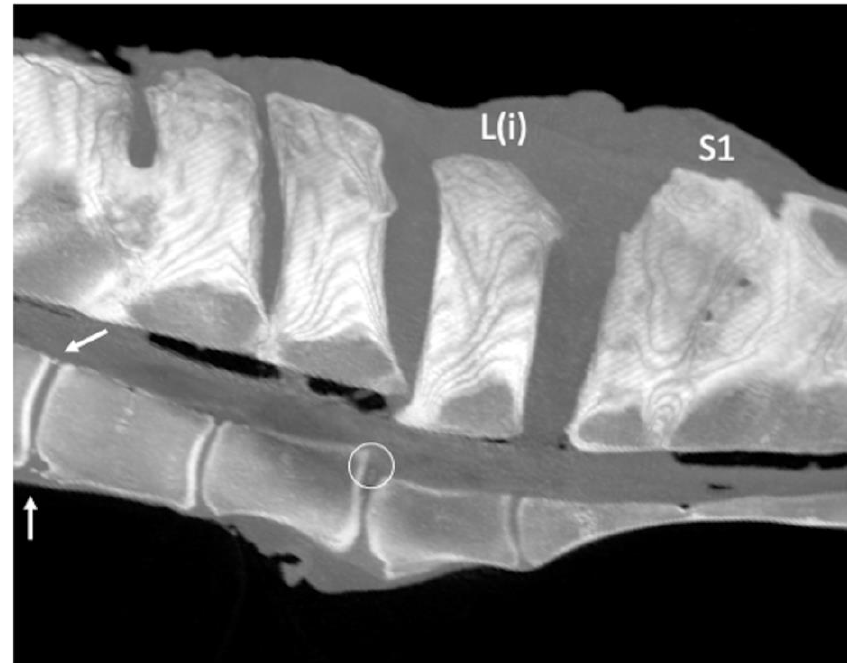
Figure 7. Sagittal multiplanar reconstruction computed tomographic image of the lumbosacroiliac specimen 1 using maximum intensity projection (MIP) (cranial is toward the left) showing the presence of a ventral displacement of L(i) and sacrum relative to the more cranial lumbar vertebrae (ventral spondylolisthesis). Note two small hyperattenuating structures at the level of the dorsal portion of the intervertebral disc (circle), L(iv)-L(iii) intervertebral osteophytes (white arrows) on both the dorsal and ventral aspects, and L(iv)-L(iii) spinous processes (SPs) fusion, as well as a fusion of the sacral SPs. L(iv): fourth to the most caudal lumbar vertebra; L(iii): third to the most caudal lumbar vertebra; L(ii): second to the most caudal lumbar vertebra; L(i): the most caudal lumbar vertebra; S1: the first sacral vertebra.